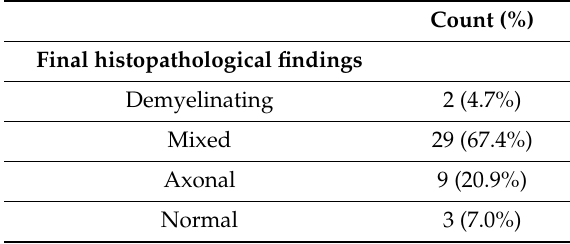
Table 1. Detailed pathological finding of 43 nerve